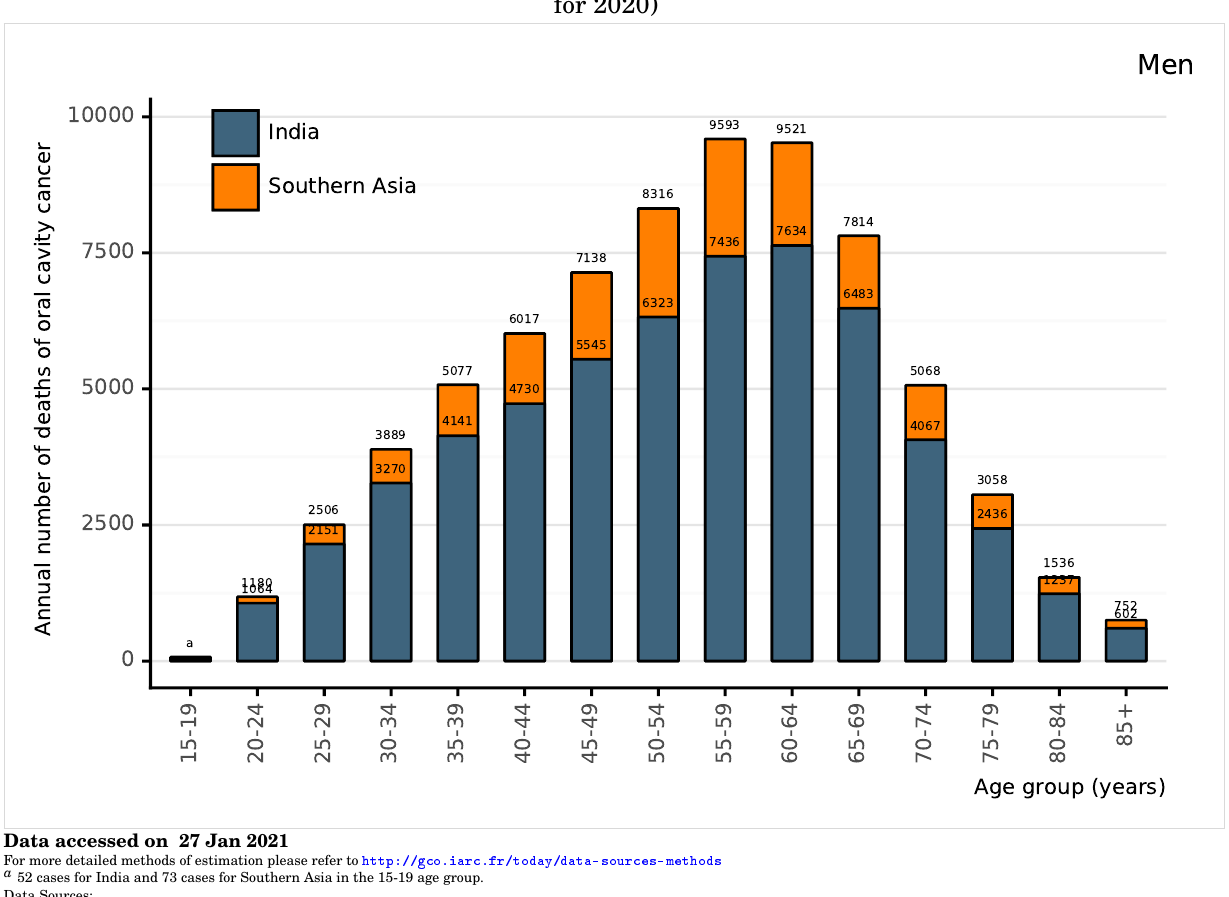
Figure 128: Annual number of deaths of oral cavity cancer among men by age group in India